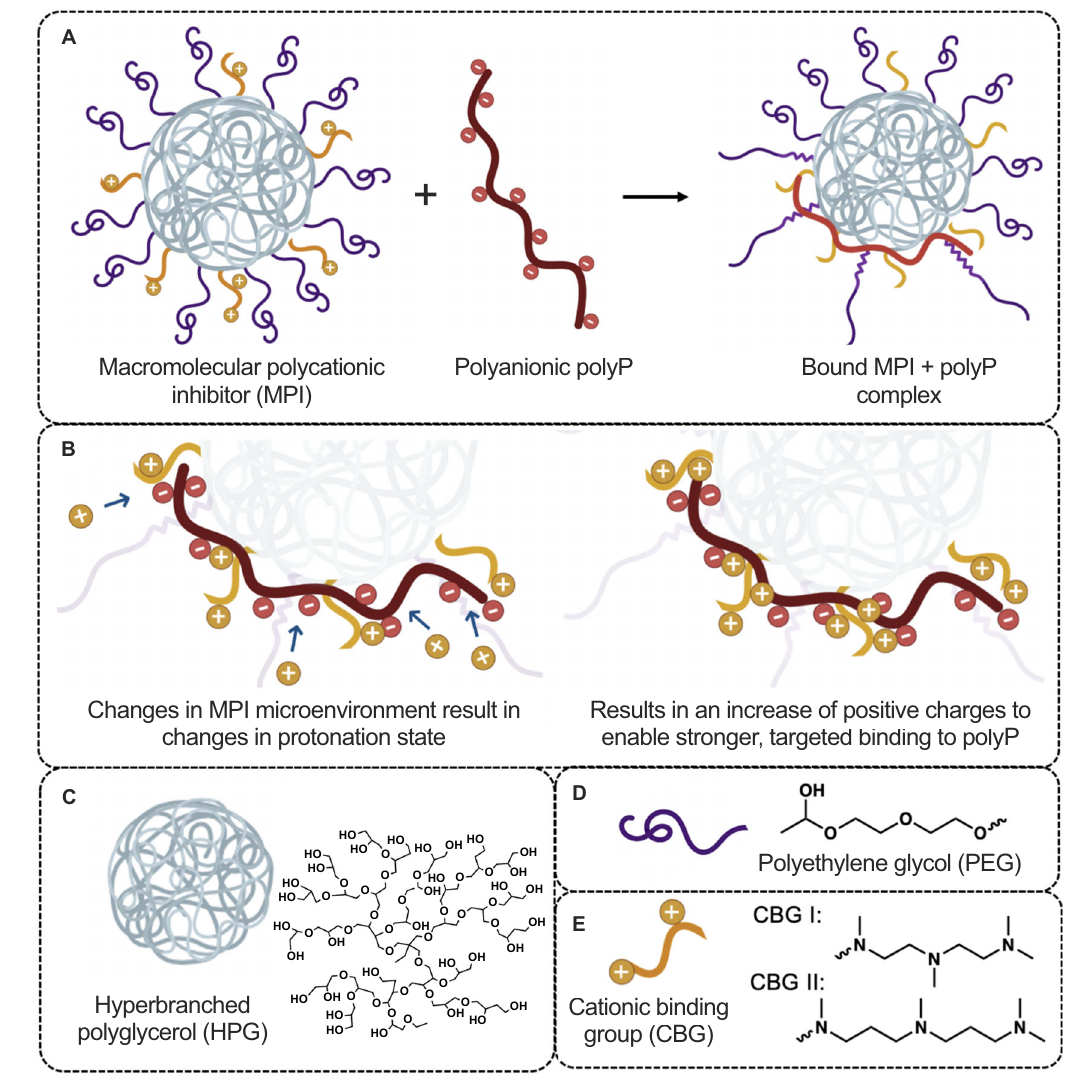
Fig. 1 | Schematic representation of general macromolecular polycationic inhibitor(MPI)bindingtopolyP.A MPIbindspolyPtoformastable(MPI+polyP) complex. B Zoom-in of charges on MPI and polyP shows that as the cationic charges on MPI initiate binding to the negative charges on polyP, the changes in the electronic microstate of MPI induce a change in the susceptibility of proto- nationofMPIamines,resultinginatunableprotonationstatecapableofrecruiting protons to successfully bind polyP. The recruitment of protons upon MPI-polyP